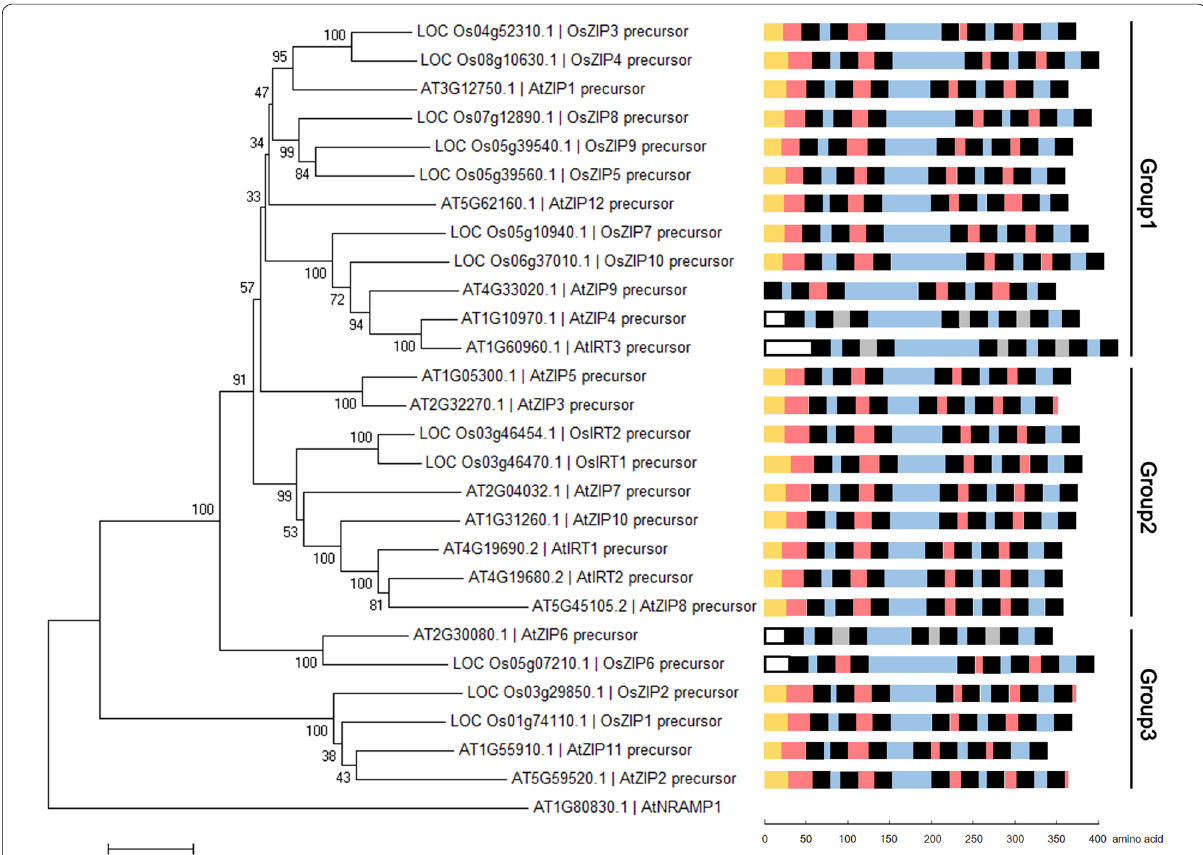
Fig. 1 Phylogenetic relationship of identified ZIPs in Arabidopsis and rice. The Neighbor-Joining tree was generated using MEGA7 with 1000 bootstrap replicates, and rooted to the AtNRAMP1. Topological structure was predicted using UniProtKB and TMHMM. Black boxes indicate TM regions. Pink boxes indicate extracellular regions. Blue boxes represent cytoplasmic regions. Gray boxes represent luminal regions. Yellow boxes represent SP region. Uncharacteristic SPs are represented by the white